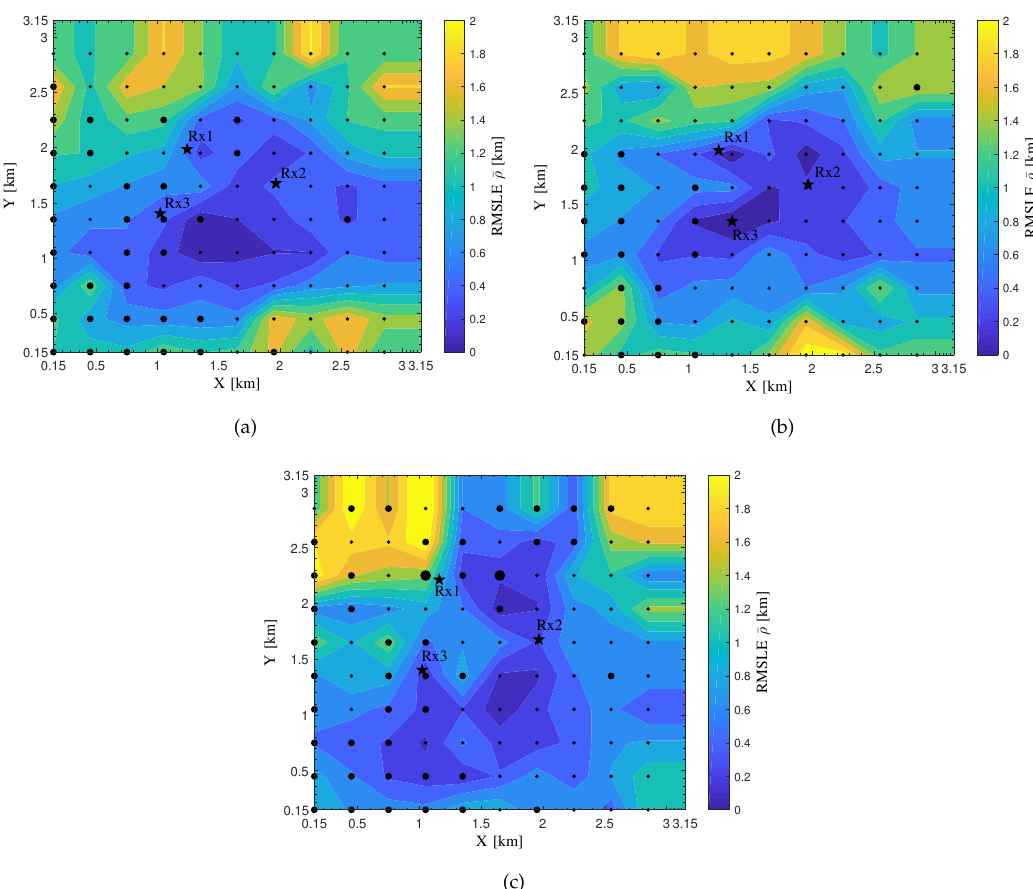
Figure 12. The RMSLE heat maps in terms of the three types of sensor placement for the realistic automobile circuit obtained from the verification of the proposed performance-evaluation approach using the commercial TDoA localization system. The sensors are marked with pentagrams while the sources with dots. ( a ) The first type of sensor placement; ( b ) The second type of sensor placement; ( c ) The third type of sensor